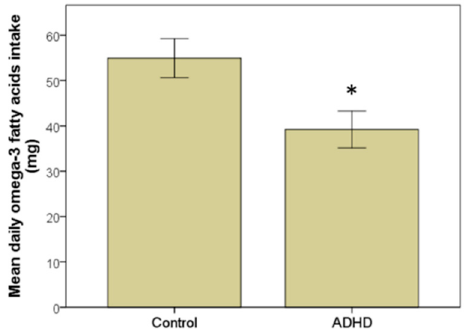
Table 2. Estimation of Omega-3 LC-PUFA intake form different type of fish and seafood.